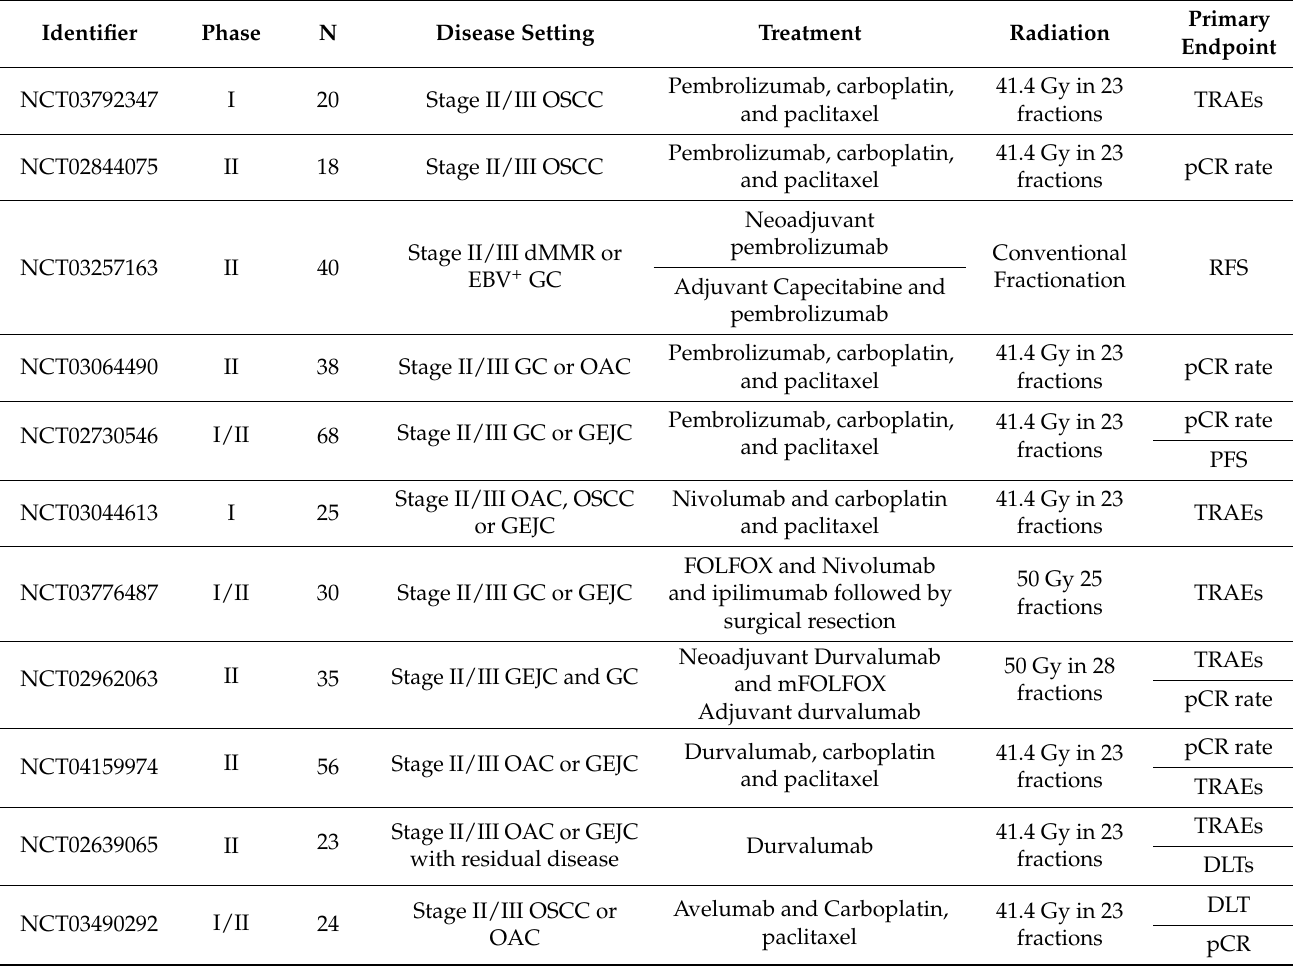
Table 1. Ongoing clinical Trials of radiation and immunotherapy in operable